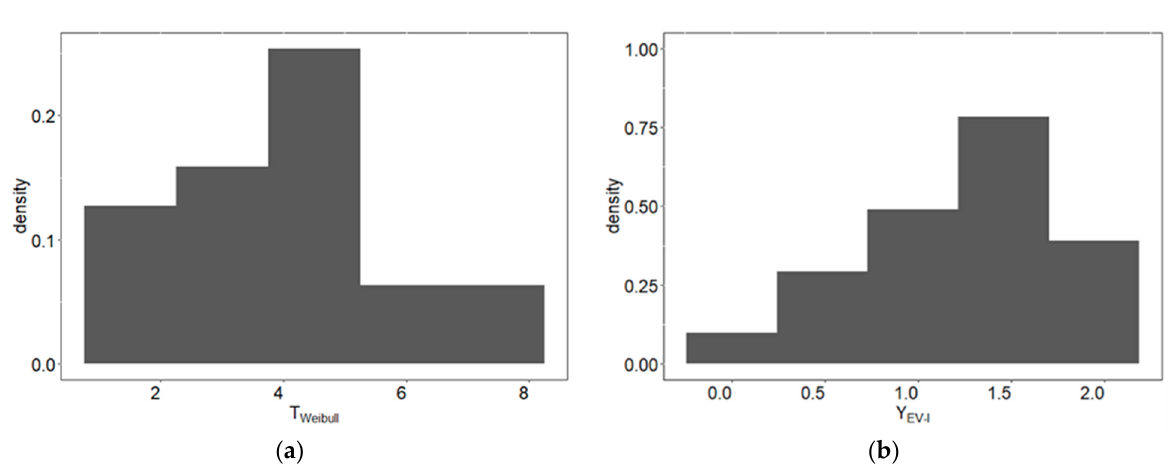
Figure 9. Histograms of DHF data in seven subdistricts in eastern Surabaya: ( a ) original data with Weibull distribution and ( b ) transformation of the original data into EV-I distribution.